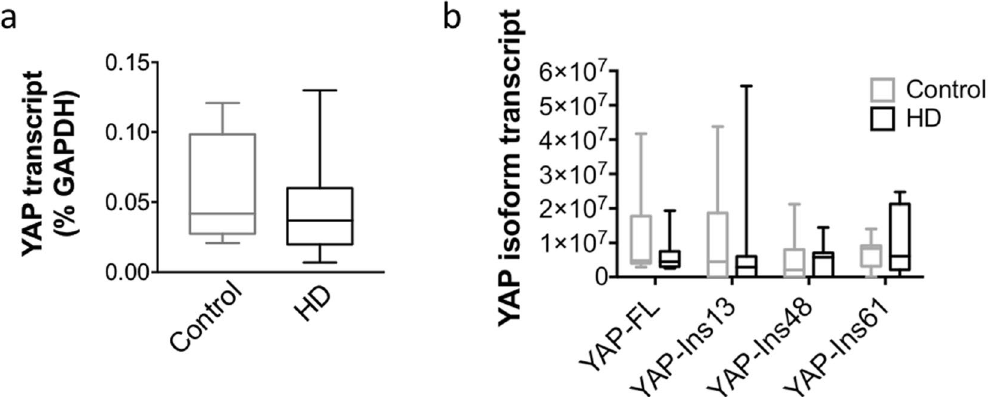
Figure 2. YAP mRNA expression in post-mortem human cortex. ( a ) Quantitative real time PCR assay illustrates no change in YAP mRNA relative to GAPDH levels (p = 0.397, Mann Whitney U test) between unaffected control (n = 5; grey) and HD (n = 12; black) patients. ( b ) Quantitative real time PCR assay also demonstrates no change (p > 0.05, Two-way ANOVA) in full length YAP (YAP-FL; left) or YAP Δ C isoforms with 13, 48, and 61 nucleotide inserts (left to right: YAP-Ins13, YAP-Ins48, and YAP-Ins61, respectively) between unaffected control and HD patients. A two-way ANOVA demonstrated that there was no significant effect of genotype [F(3, 68) = 0.775, p = 0.512], YAP isoform [F(1, 68) = 0.282, p = 0.597], or interaction [F(3, 68) = 0.383, p = 0.765] in control (n = 8; grey) and HD (n = 11; black) patients. Data are presented as median